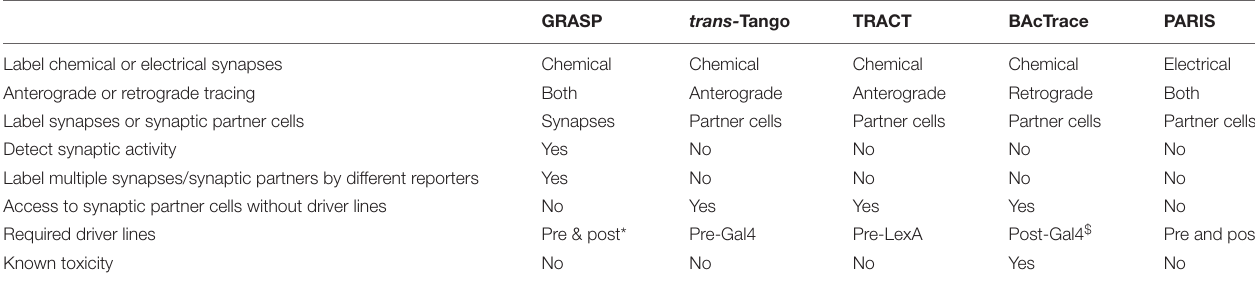
TABLE 1 | Comparison of genetic transsynaptic